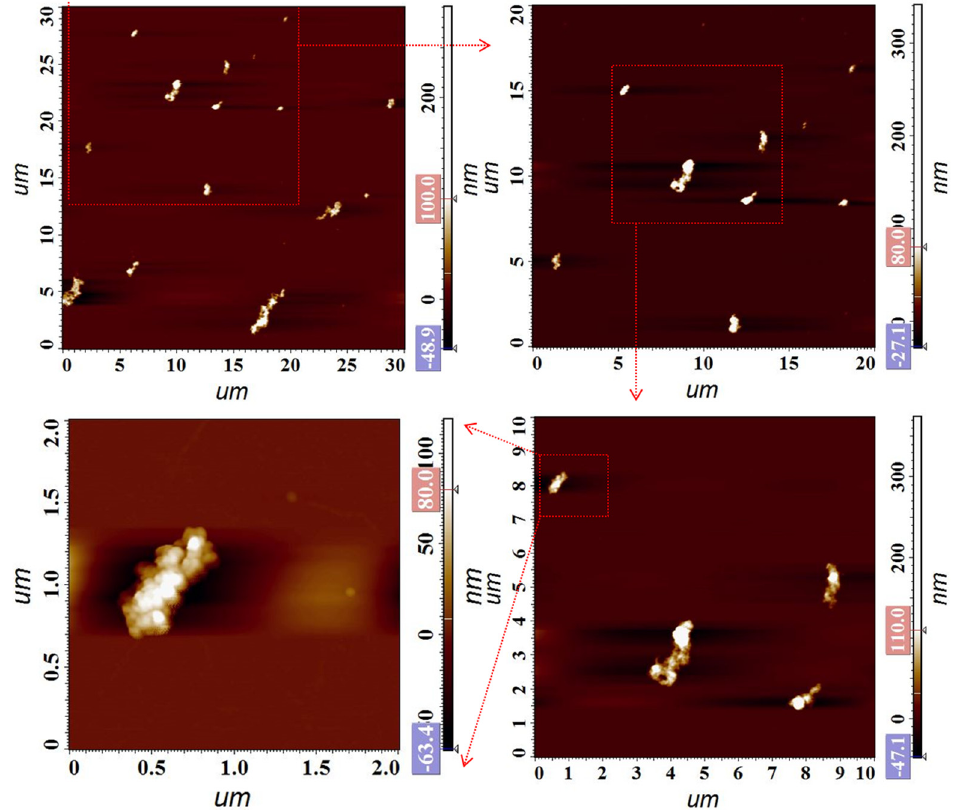
Figure 7. AFM characterization of AuNPs@Ru(bpy) 32+ -SA in complex with dual-labeled phage display affibodies.